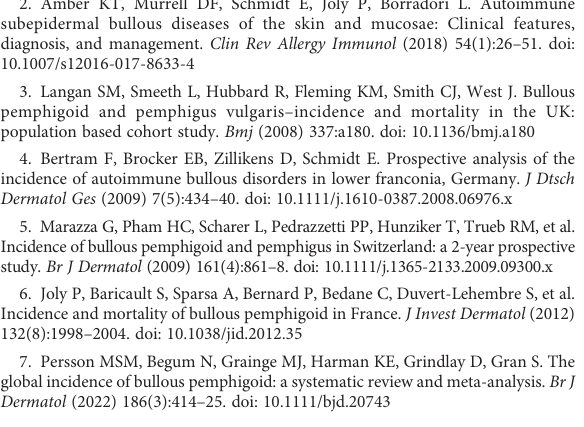
SUPPLEMENTARY FIGURE 3 Immuno fl uorescence staining showed expression of C5aR1 (A) and C5aR2 (B) on epithelial cells and vascular endothelial cells. DAPI staining of nuclei is shown in blue. Scale bars, 100 µm. SUPPLEMENTARY FIGURE 4 The speci fi city of the anti-C5aR2 antibody was validated by coincubation with increasing amounts of a C5aR2 peptide. Sections of randomly selected BP skin were stained with isotype control antibody (A) , anti- C5aR2 antibody alone (B) , and anti-C5aR2 antibody plus increasing amounts of the C5aR2 peptide (RRLHQEHFPARLQCVVDYGGSSSTEN), i.e. 0.1 (C) , 0.5 (D) , 1 (E) , 5 (F) , 25 (G) , and 50 µg (H) , respectively. A dose-dependent inhibition of the IF staining was seen with the increasing C5aR2 peptide amounts indicating a high speci fi city of the anti-C5aR2 antibody. Incubation of the anti-C5aR2 antibody with 50 µg of an irrelevant control peptide did not alter the IF staining (data not shown). Data are representative of results obtained from three experiments. Scale bars, 100 µm. SUPPLEMENTARY FIGURE 5 In site-matched skin biopsies of age- and sex-matched control patients (n=4), only few in fl ammatory cells were detected with low expression of C5aR1 (A) and C5aR2 (B) . SUPPLEMENTARY FIGURE 6 Plasma levelsofC5b-9,C5a,factorh,andfactorbaswellasserumactivity of the classical (CP) and alternative complement (AP) pathways in patients with bullous pemphigoid (BP) and controls. (A-F) Plasma levels of C5b-9 (A) ,C5a (B) , factor h (C) , andfactorb (D) as wellasserumactivity ofthe CP (E) and the AP (F) in BP patients (n=10) and age- and sex-matched controls (n=10) did not show signi fi cant differences. (G-L) Plasma levels of C5b-9 (G) , C5a (H) , factor h (I) , and factor b (J) as well as serum activity of the CP (K) and the AP (L) in BP patients did not signi fi cantly correlate withdiseases activityasmeasuredbythebullouspemphigoiddiseasearea index (BPDAI). Differences between groups were analyzed by unpaired two-tailed t-test. n.s., not signi fi